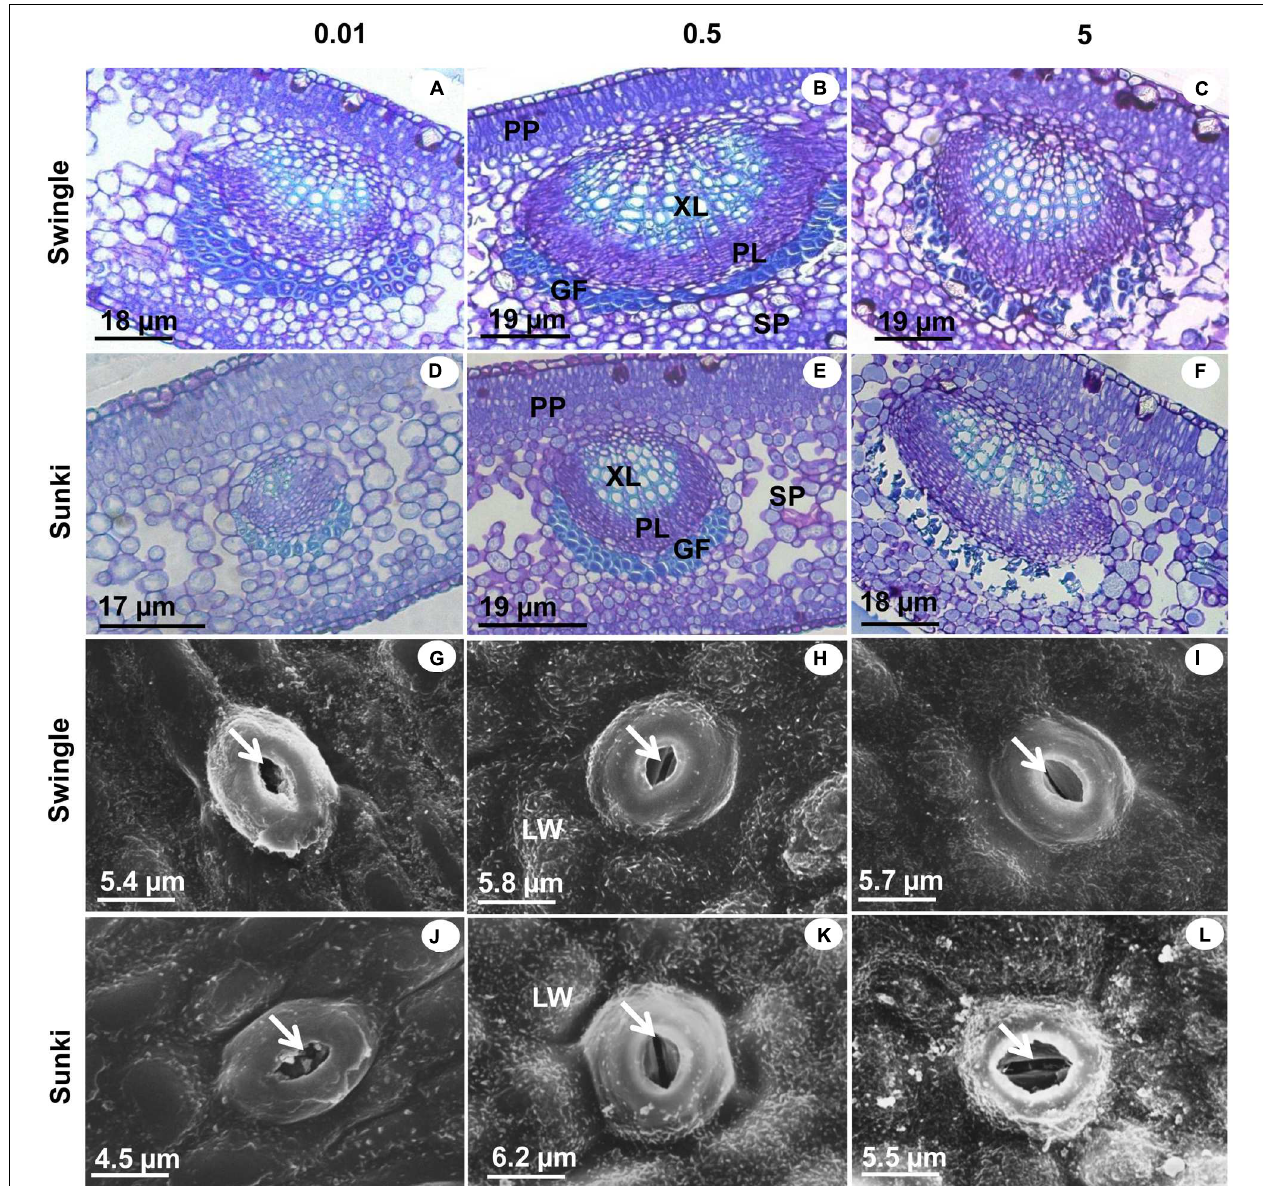
FIGURE 5 | Cross sections of leaves under light microscopy (LM) and scanning electron microscopy (SEM) of sweet orange trees grafted on Swingle (LM: A–C; SEM: G–I) or Sunki (LM: D–F; SEM: J–L) rootstocks grown in nutrient solution with varying concentrations of B for 130 days. Concentration of nutrient solution, in mg L − 1 of boron: left (0.01), center (0.5), and right (5.0) columns. Legend: PP, palisade parenchyma; SP, spongy parenchyma; XL, xylem; PL, phloem; GF, gelatinous fibers; LW, leaf wax; GC, guard cell; arrowhead: ostiole.